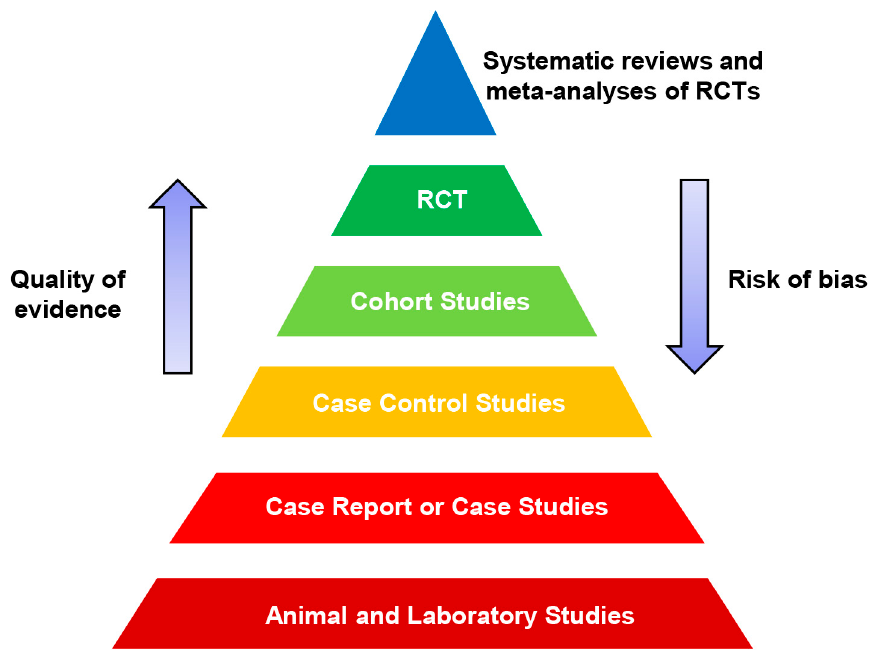
Figure 2. Hierarchy of evidence pyramid. RCT—randomized controlled trial.